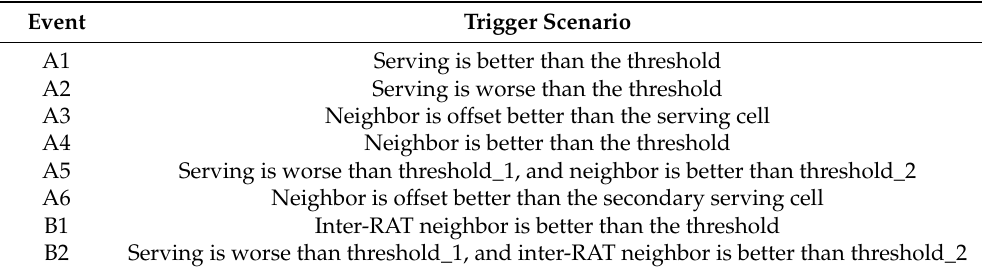
Table 1. Measurement report yriggering.